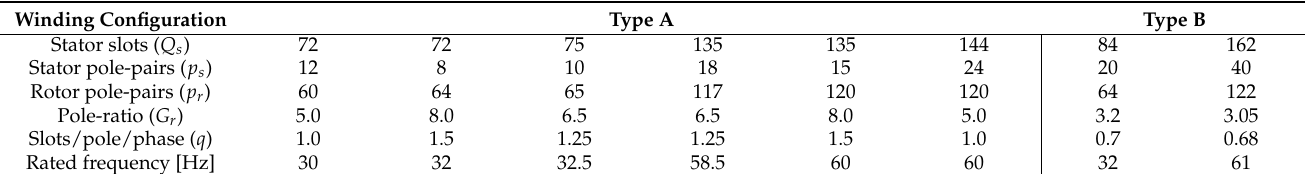
Table 3. Investigated slot/pole combinations for 1MW PMVMs.